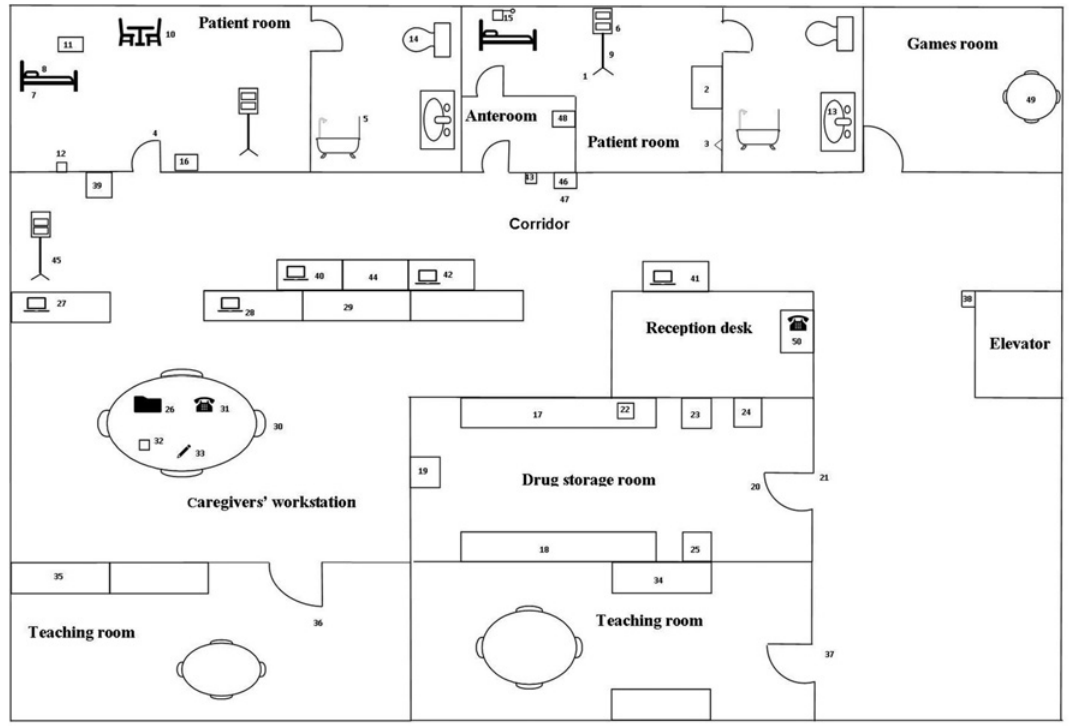
Figure 1: Map showing the 50 distinct sampling